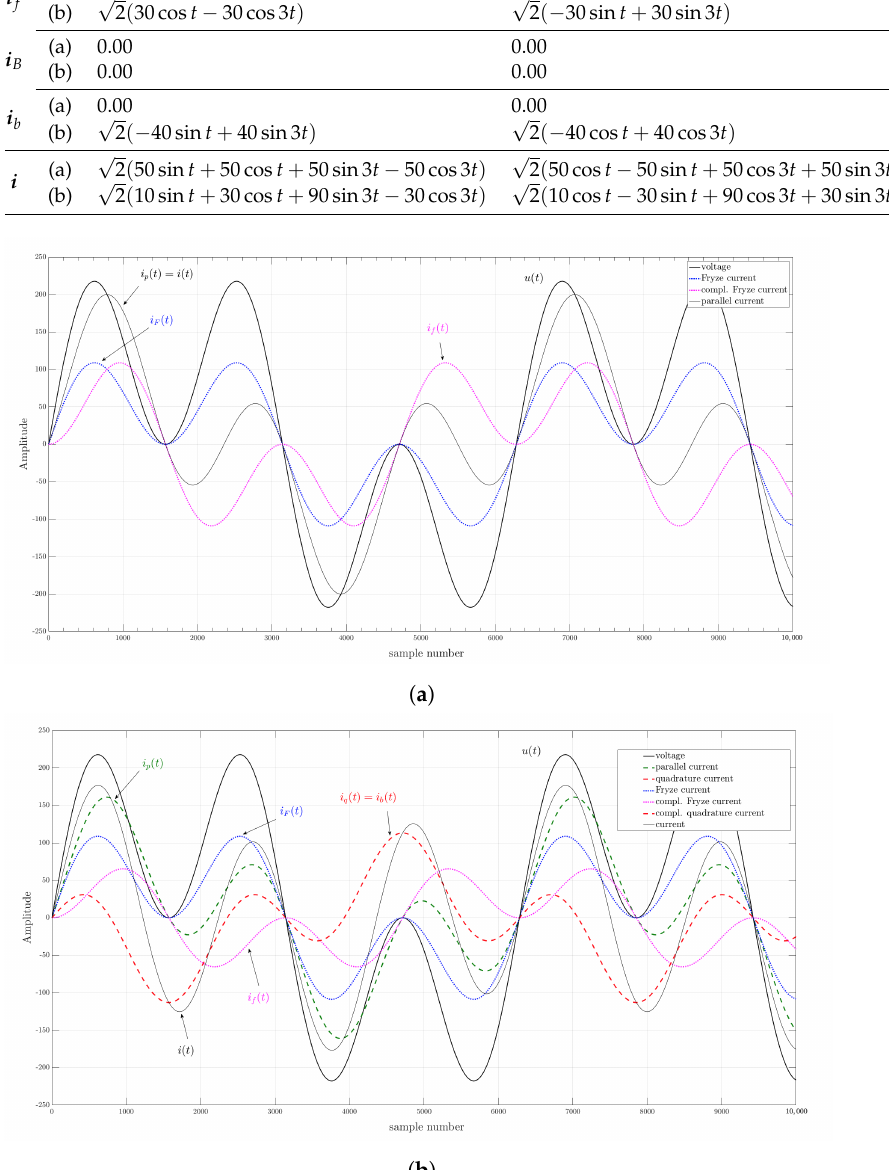
Figure 3. Currents in time domain for the circuits in Figure 2. The signals for circuit ( a ) are shown at the top and the values for circuit ( b ) at the bottom. Time samples are depicted on the x axis and amplitude of current/voltage on the y